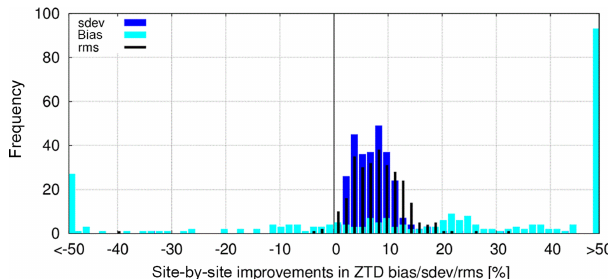
Figure 12. Site-by-site ZTD improvements of EPN-Repro2 versus EPN-Repro1 compared to